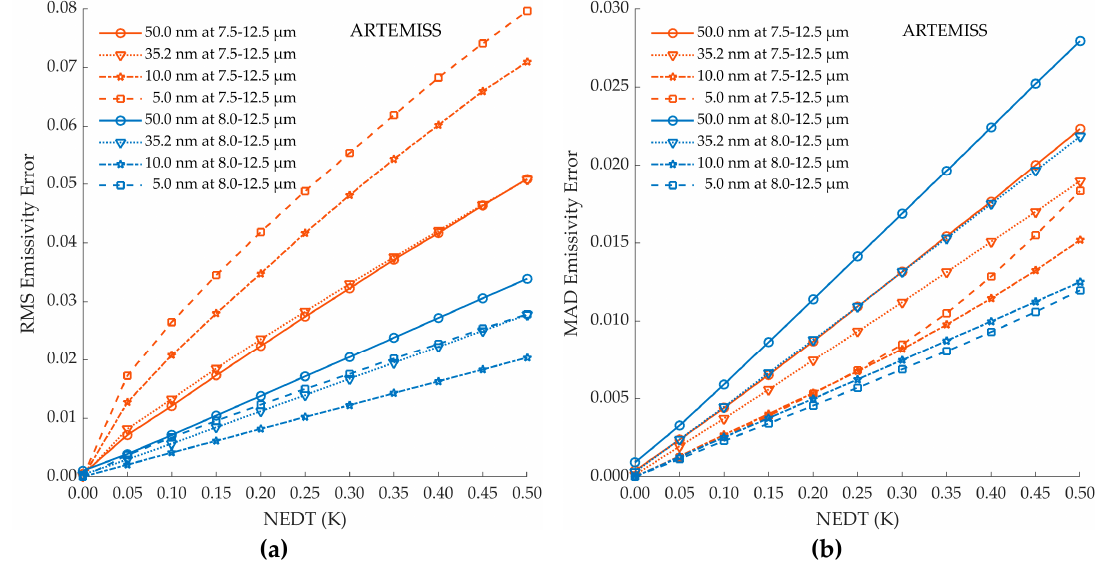
Figure 2. Plots of ARTEMISS retrieved land surface emissivity (LSE) errors varying with NEDT, spectral range and spectral resolution. ( a ) The retrieved LSE root mean square error (RMSE) and ( b ) the retrieved LSE median absolute deviation (MAD).